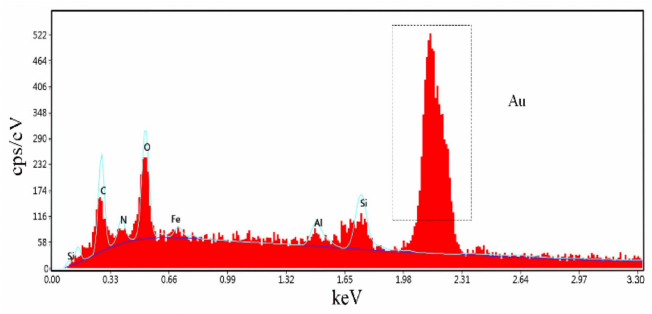
Figure 2. Energy spectrum analysis of carbonaceous